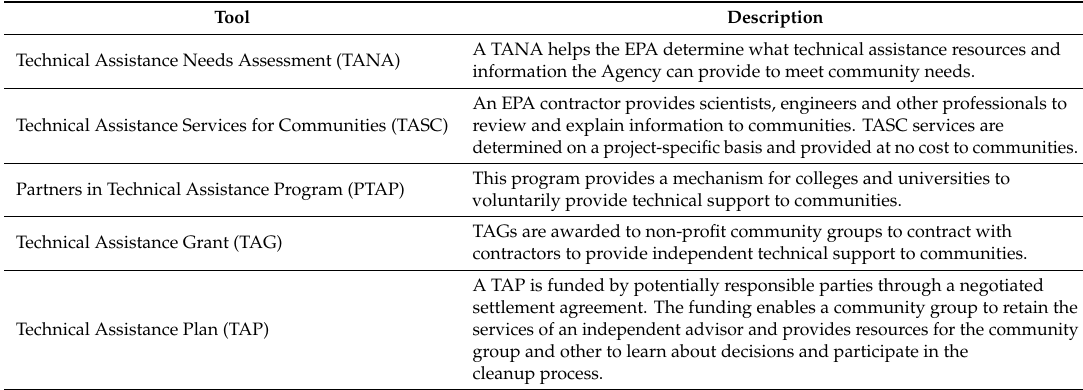
Table 1. Methods that the Environmental Protection Agency (EPA) employs to promote community participation